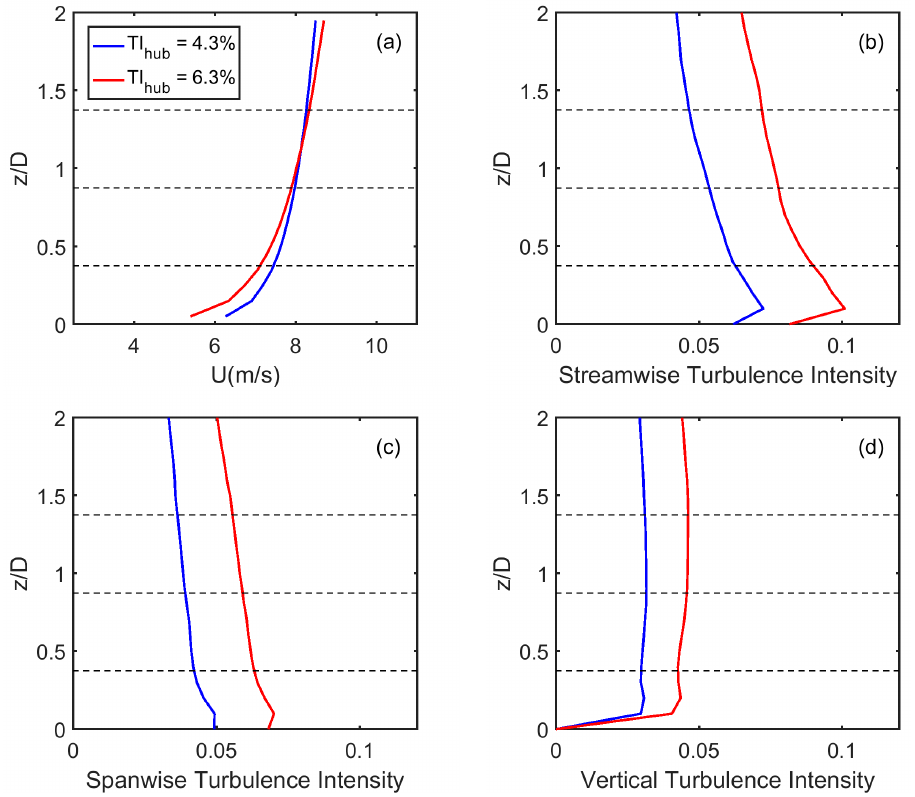
Figure 2. Vertical profiles of ( a ) time-averaged streamwise velocity U (m s − 1 ), ( b ) Streamwise turbulence intensity I u = σ u / U hub , ( c ) Spanwise Turbulence intensity I v = σ v / U hub , ( d ) Vertical Turbulence Intensity I w = σ w / U hub , of the incoming boundary layers. The horizontal dotted lines show the top tip, hub and bottom tip heights of the turbine.